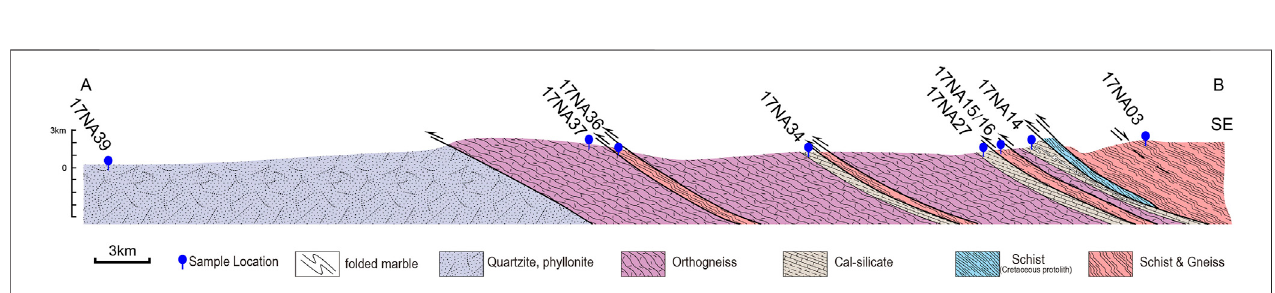
FIGURE 2 | Schematic geological pro fi les of eastern limb of the Arun Valley. Dashed line represents local detached ductile fault.